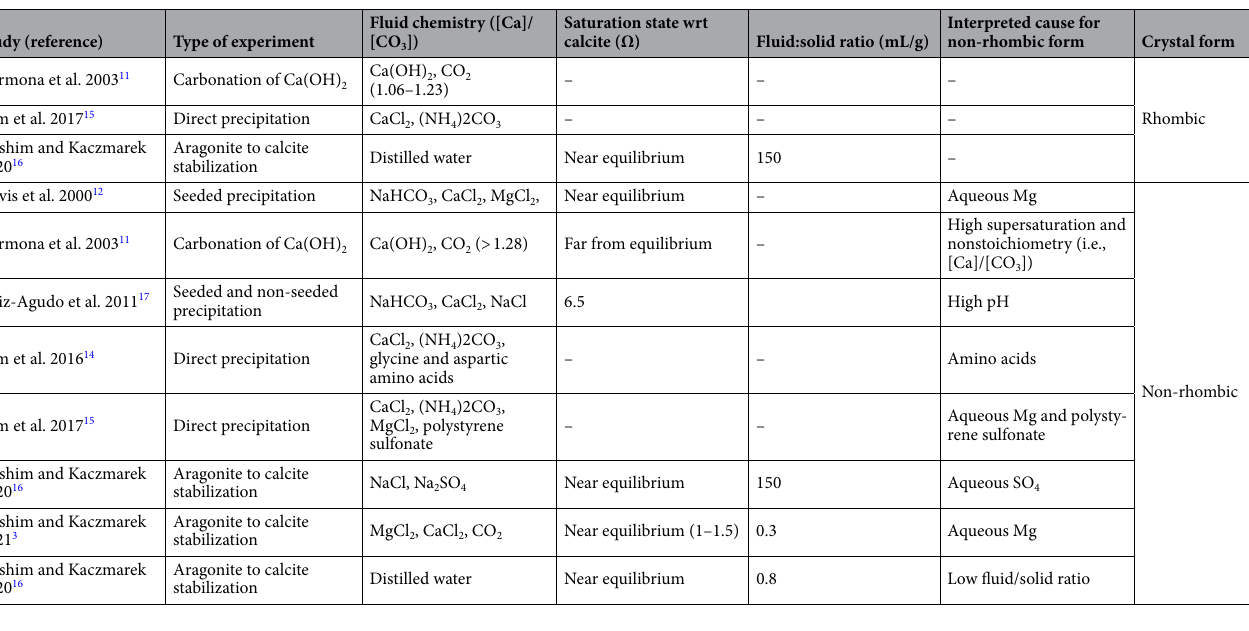
Table 2. Observations from previous experimental studies showing the conditions under which rhombic and non-rhombic calcite microcrystals form.